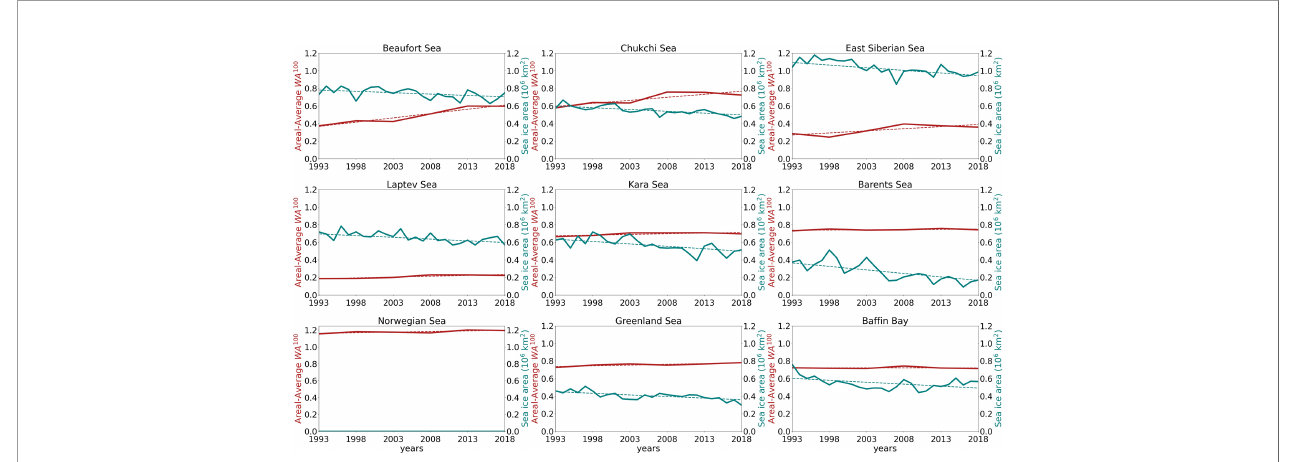
FIGURE 7 | Temporal variation of the yearly areal-average of sea ice area (sea ice extent, blue line) and aerial-average of wave age associated with 100-year events (red line). Areal trends are shown as dashed